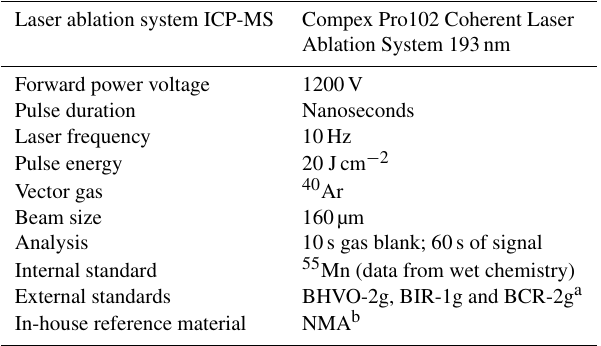
Table 2. LA-ICP-MS analytical parameters